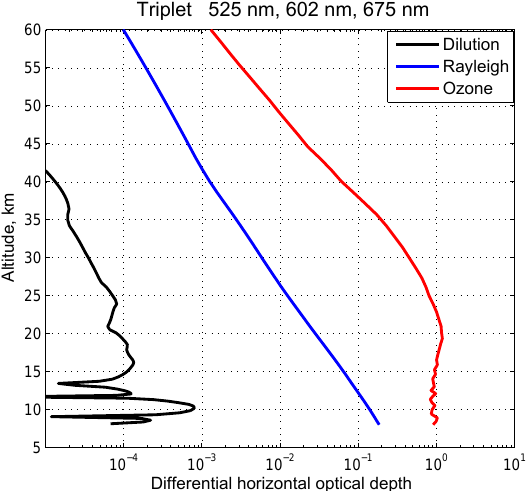
Figure 6. Differential horizontal optical depth for the visible triplet 525, 602, and 675nm (see text for definition) due to ozone absorp- tion, Rayleigh scattering, and dilution. The contributions are com- puted based on the occultation